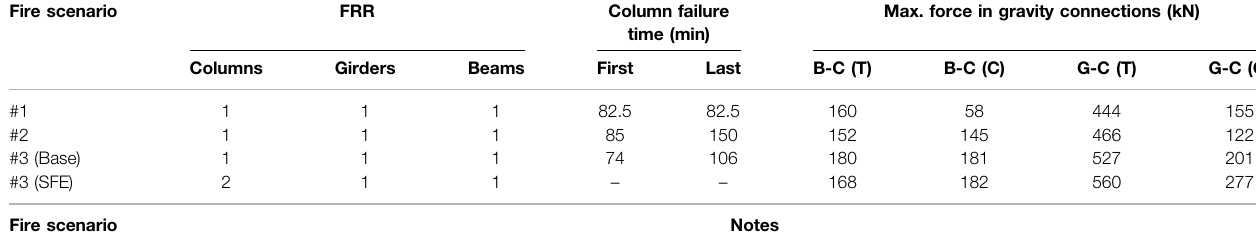
TABLE 2 | Summary of Building behavior in fi re scenarios. Fire